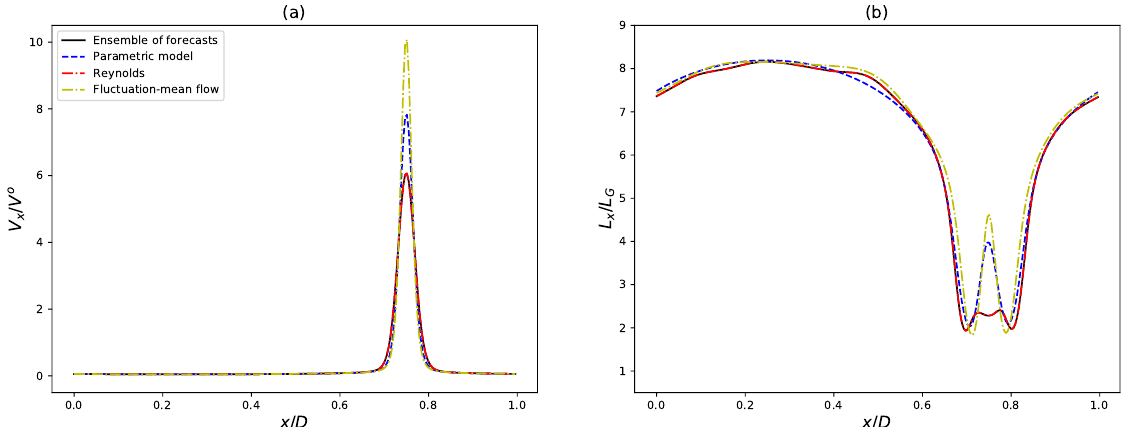
Figure 7. Verification of the parametric variance (a) and correlation length scale (b) at t = T and for an initial perturbation standard deviation σ 0 . The statistics from the ensemble of nonlinear forecasts of Eq. (12) are shown by the black line, the statistics predicted by the parametric 10% model are shown by the blue dashed line, and the statistics from the Reynolds equations (Eq. 13a, 13b) (from the fluctuation–mean flow dynamics shown in Eq. 14a and 14b respectively) with (without) the second-order term ε∂ x ε are shown by the small red dashed-dotted line (yellow dashed-dotted